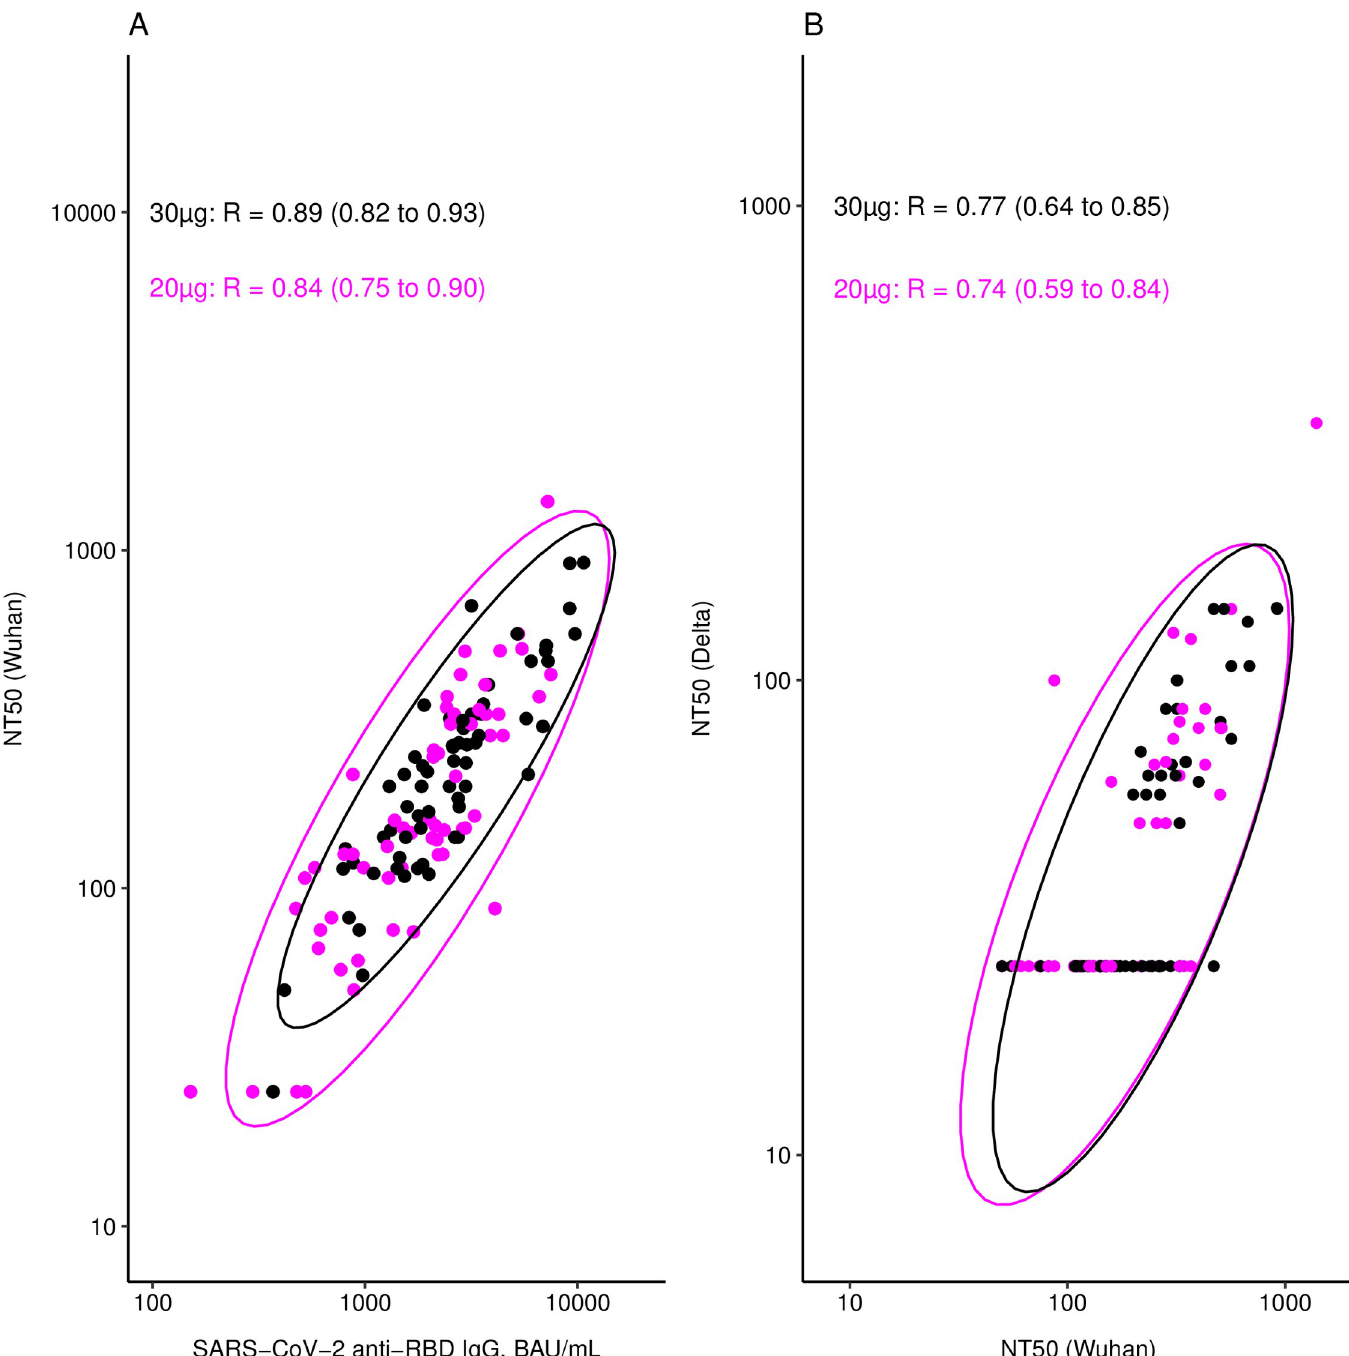
Fig 3. Correlations between immune responses per study arm. Correlations were analysed at 28 days after the second vaccine dose between SARS-CoV-2 anti-RBD IgG binding antibodies and SARS-CoV-2 Wuhan neutralizing antibodies (A), and between SARS-CoV-2 Wuhan and Delta variant neutralizing antibodies (B). Pearson correlation coefficients (95% CI) are given per study arm. Ellipses represent the 95% CI for the two study arms (purple = 20 μ g, black = 30 μ g), assuming multivariate normal distributions. NT50 = 50% neutralizing antibody titre, RBD = SARS-CoV-2 receptor binding domain, BAU = binding antibody units.